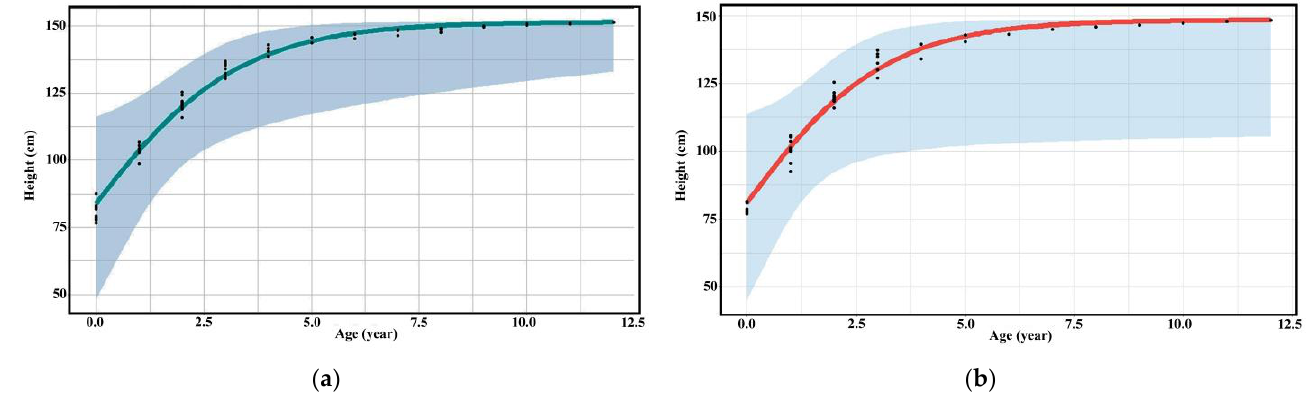
Figure 2. Relationship between age and height of ( a ) male and ( b ) female captive banteng by re- Figure 2. Scatter diagram (black dots) with regression line of the relationship between age and height searchers. of ( a ) male and ( b ) female captive banteng by researchers.